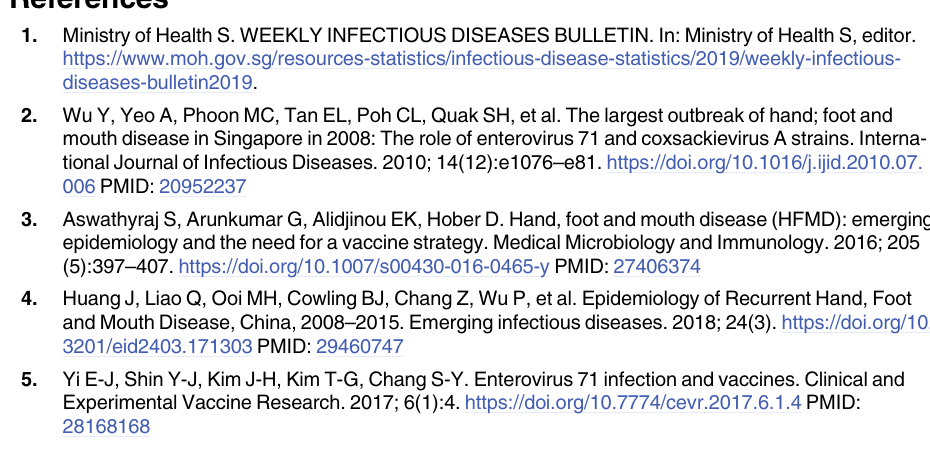
S3 Fig. Distribution of subclinical infection across all childcare centers sampled in this study. Based on the Pan-Entero RT-PCR assay, the subclinical infections were dispersed across all the childcare center sampled, revealing a basal level of subclinical infection across most childcare centers. S4 Fig. Distribution of subclinical infection across various age groups. Subclinical infec- tions were stratified according to the different ages of the